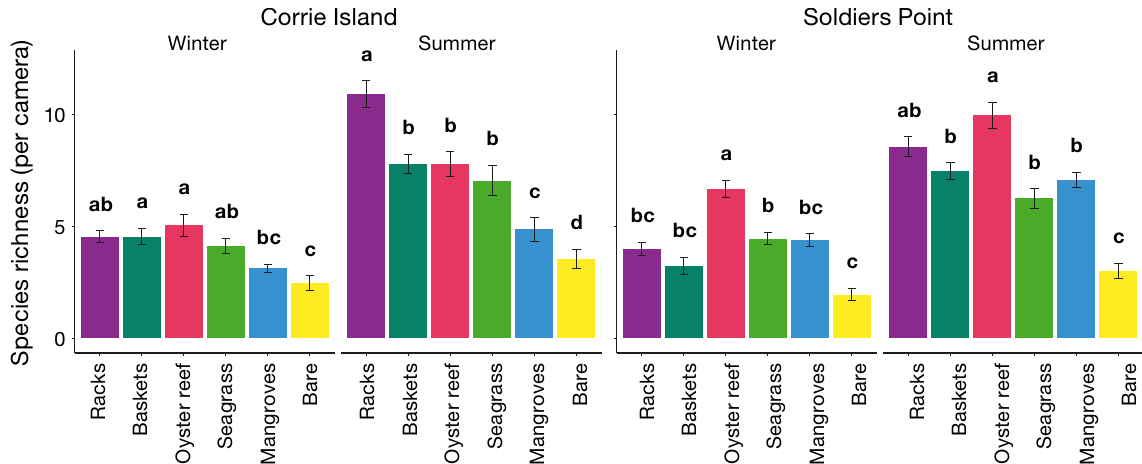
Fig. 5. Mean (±SE) species richness per habitat, site and season as documented by 75 min remote underwater video deploy- ments. Data are averaged across the 2 study years, as these did not significantly differ, with 4 cameras deployed on 3 repli- cate days of each season and year, to give n = 24. Letters above columns denote treatments that were significantly different (at α = 0.05) within each site and season by estimated marginal